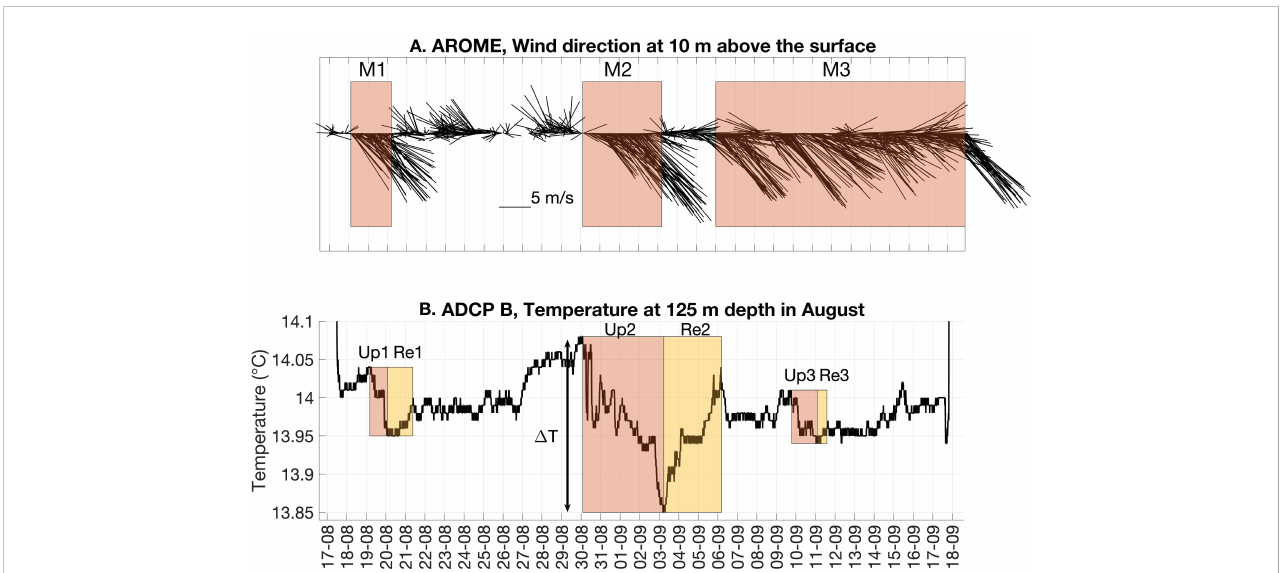
FIGURE 2 (A) Wind direction determined using the AROME meteorological model hindcasts during the UPCAST 2017 cruise. The stickplots point in the direction of the wind. Stickplots directed towards south-east to east (red boxes ‘ M 1 ’ , ‘ M 2 ’ and ‘ M 3 ’ ) correspond to Mistral events. (B) Temperature record (°C) measured at 125 m depth by the ADCP B (UPCAST 2017 cruise) under strati fi ed conditions. Upwelling (red boxes ‘ Up 1 ’ , ‘ Up 2 ’ and ‘ Up 3 ’ ) generated by ‘ M 1 ’ , ‘ M 2 ’ and ‘ M 3 ’ respectively induce a decrease of temperature D T in the water column. Their corresponding relaxation ‘ Re 1 ’ , ‘ Re 2 ’ and ‘ Re 3 ’ are represented by the yellow